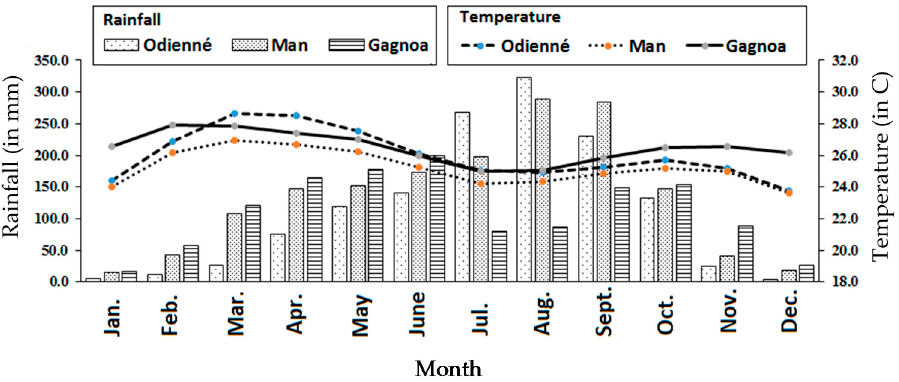
Figure 1. Sassandra River Basin at Soubré.